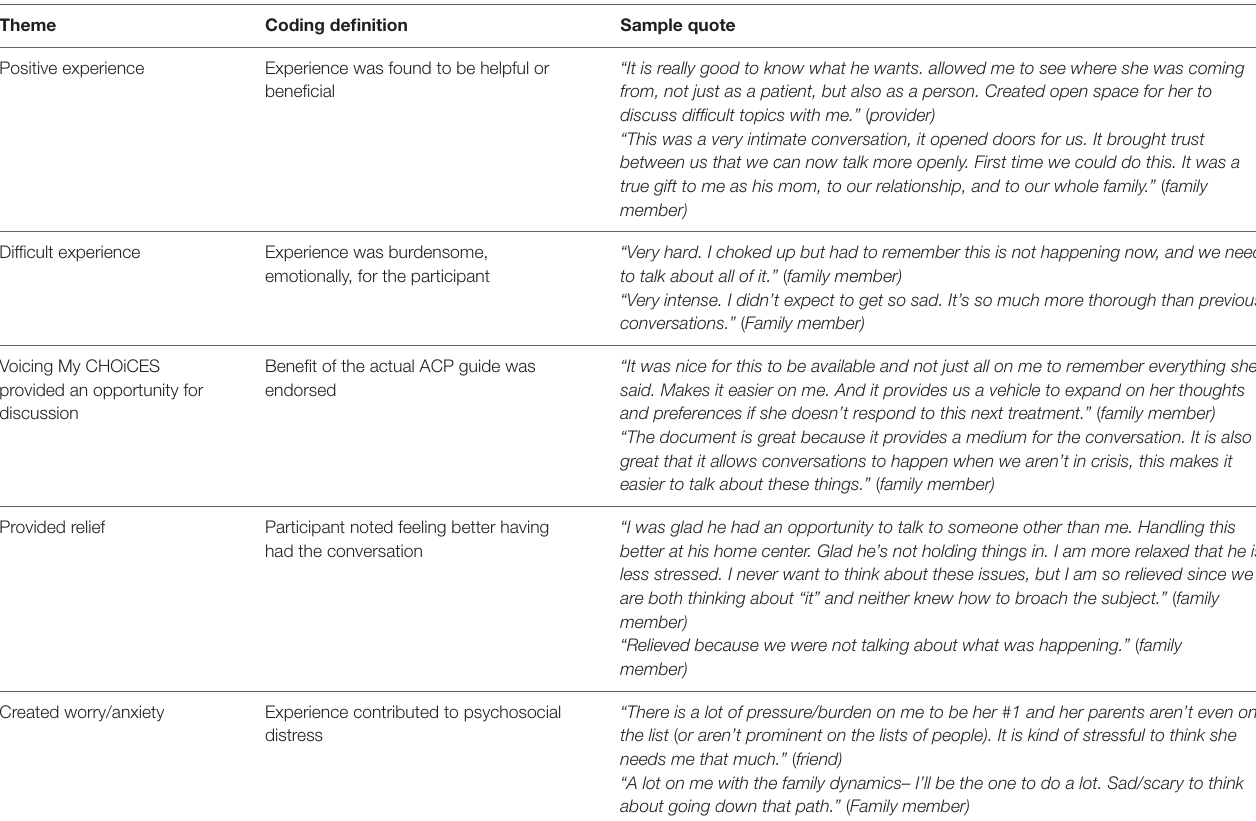
TABLE 3 | Participant perceptions of the ACP